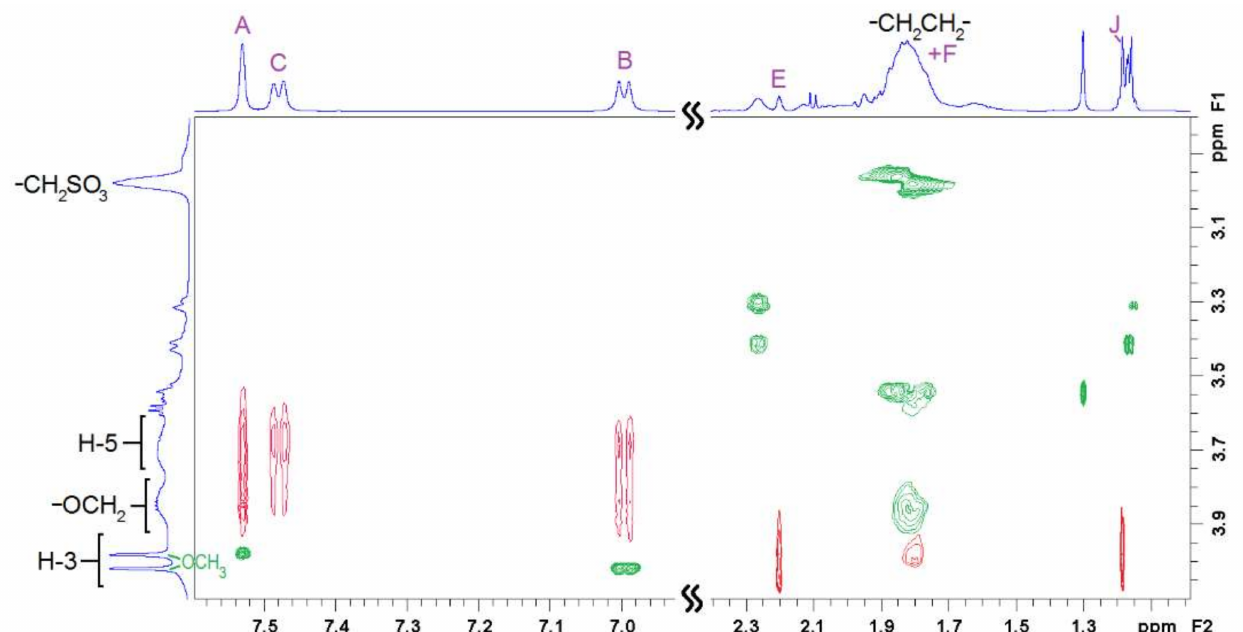
Figure 5. Two-dimensional ROESY NMR spectrum of the 1:1 VTD:SBCD inclusion complex showing intermolecular ( red ) and intramolecular ( green ) cross-peaks. See Figure 1a,c for atom labelling.